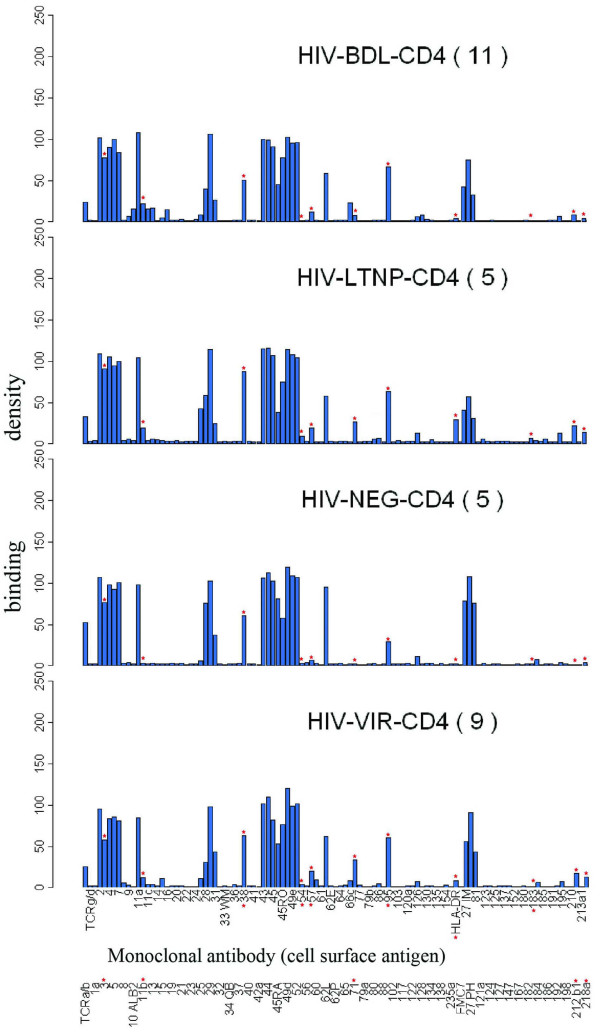
Antibody response charts of CD4+ T cells. The bar charts represent the average immunophenotypes, or signatures, for each of the disease categories. Asterisks show the antigens which were significantly up-or down-regulated in paired comparisons of the disease groups. Labeling on the x-axis refers to monoclonal antibodies and their specificities against the corresponding antigens and the y-axis the binding densities.